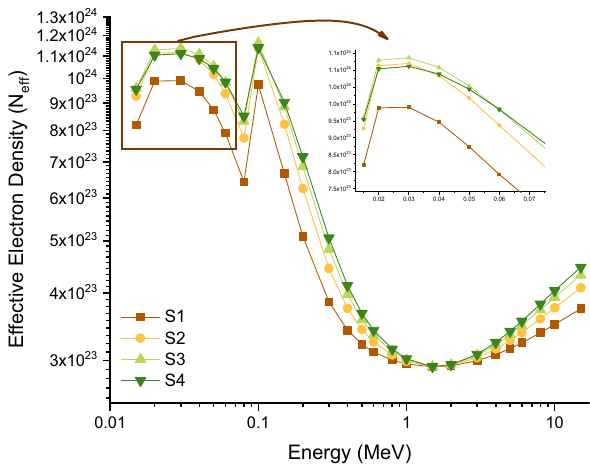
Figure 12: Variation of e ff ective electron density ( electrons/g ) with photon energy ( MeV ) for all S1 – S4 glasses.